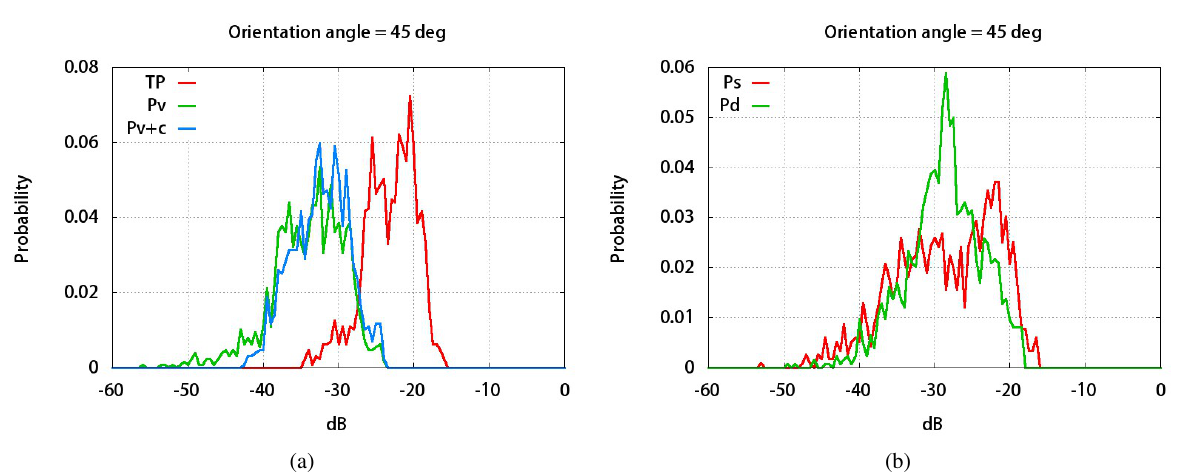
Figure 8. Histograms of scatterings when the orientation angle of the concrete blocks was set to 45 ◦ . (a) TP , P v , and P v + c , and